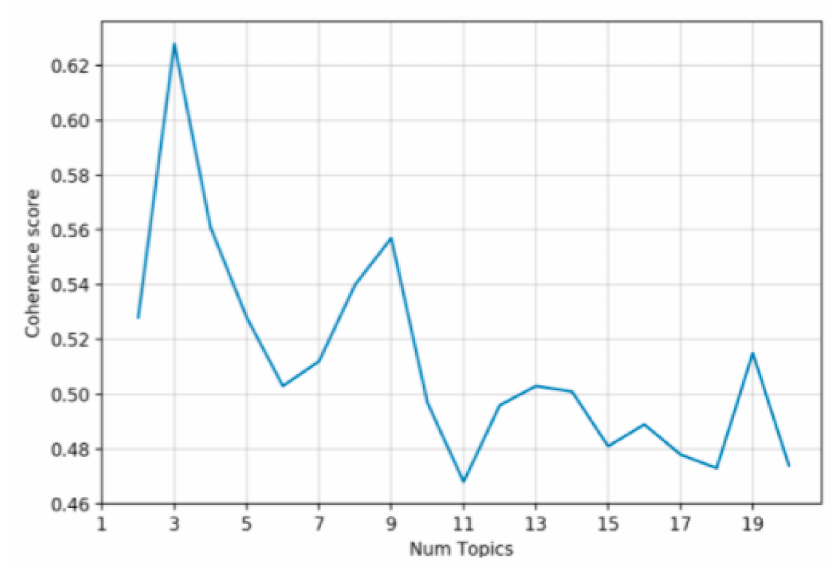
Figure 3. Topic number and coherence score in July 2019. Table 4. Topics and keywords of posts in July 2019.